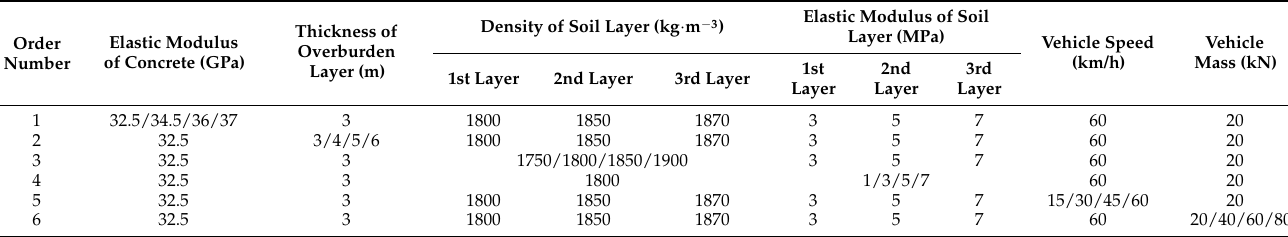
Table 2. Numerical simulation conditions.